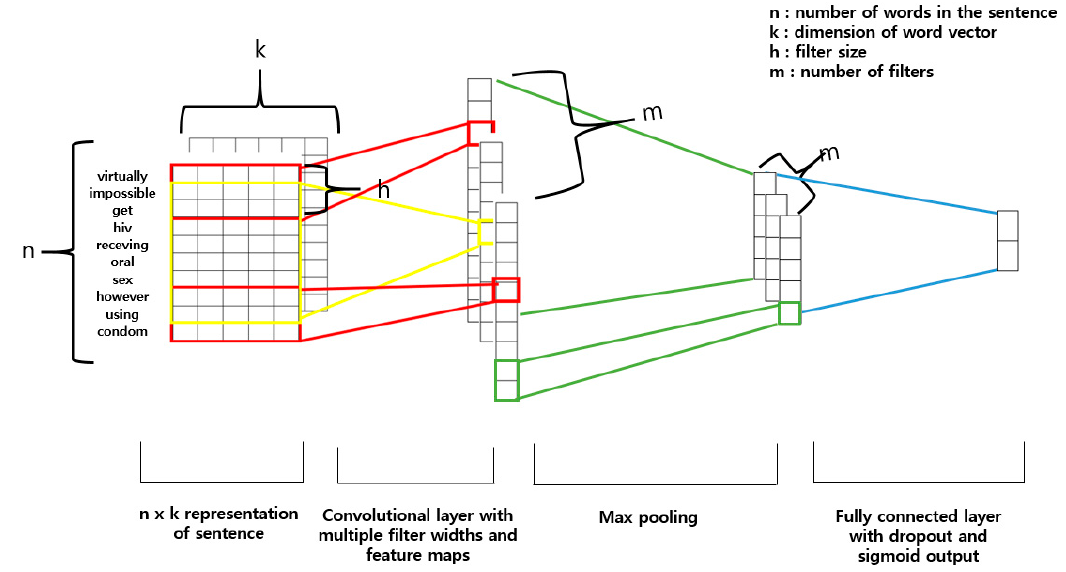
Figure 3. Model architecture with an example sentence.